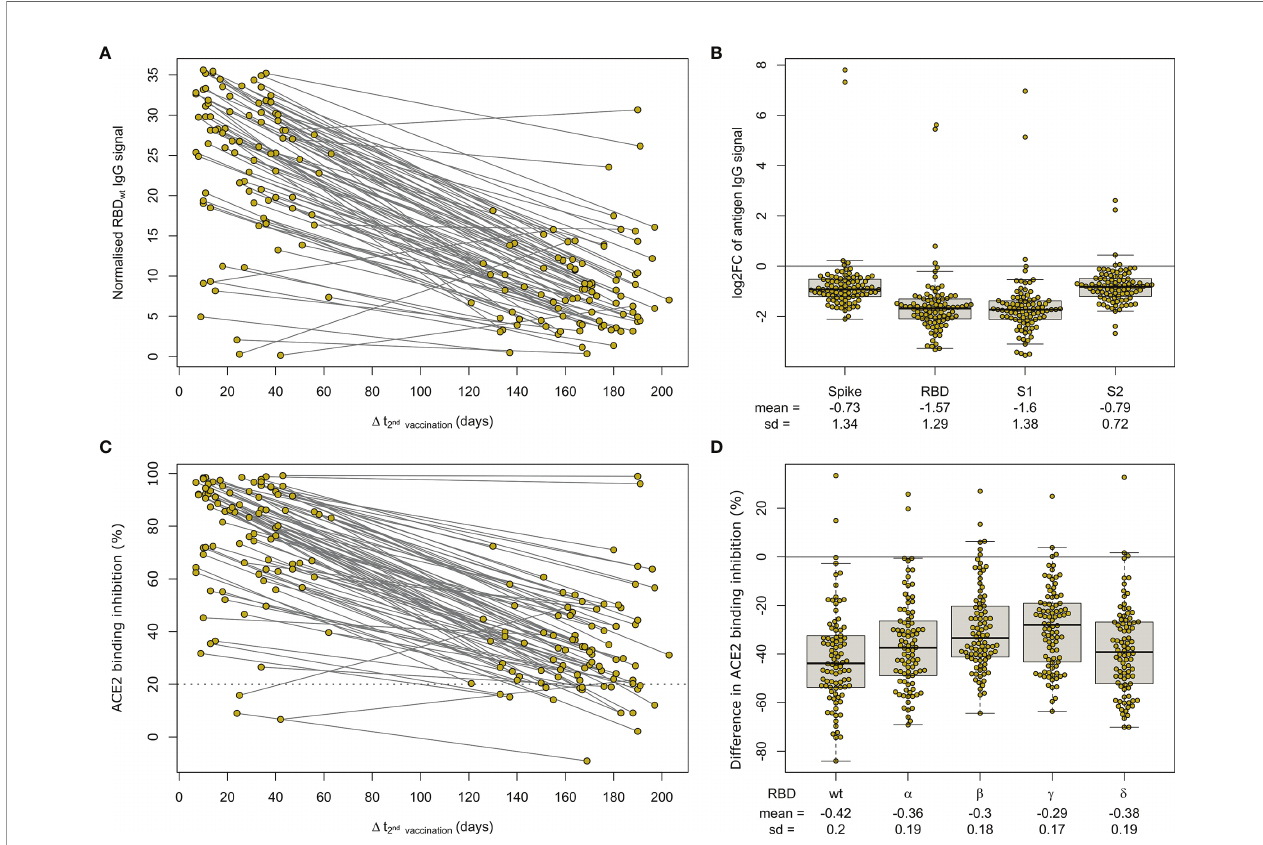
FIGURE 7 | Longitudinal mRNA vaccine response monitoring de fi nes decreases over time. Humoral response was assessed by MULTICOV-AB (A, B) and an ACE2- RBD competition assay (C, D) for all samples of the paired longitudinal sample set at indicated time points post-second dose of 90 individuals after a two-dose BNT162b2 vaccination. Line graph illustrates longitudinal development of RBD-speci fi c antibody levels (A) or ACE2 binding inhibition (C) towards WT RBD as time post- vaccination increases. The threshold (less than 20% ACE2 binding inhibition) for non-responsive samples within the ACE2-RBD competition assay is shown (dotted line). All samples below this threshold are considered non-responsive. SARS-CoV-2 antigen-speci fi c differences in longitudinal humoral response are expressed as log2 fold changes (B) . Reduction in ACE2 binding inhibition for RBD of Alpha, Beta, Gamma and Delta VoC between sampling times is shown as difference (D)